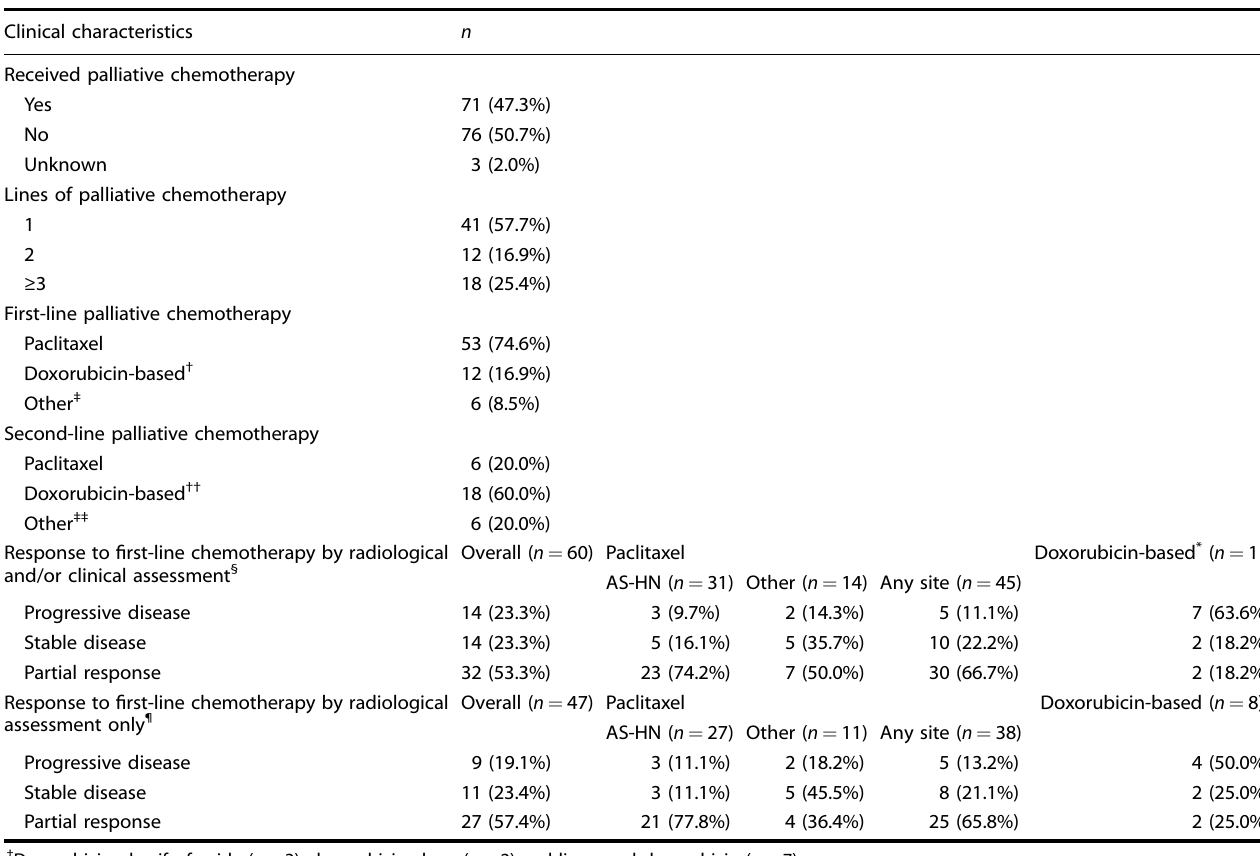
Table 5. Palliative chemotherapy received by patients with